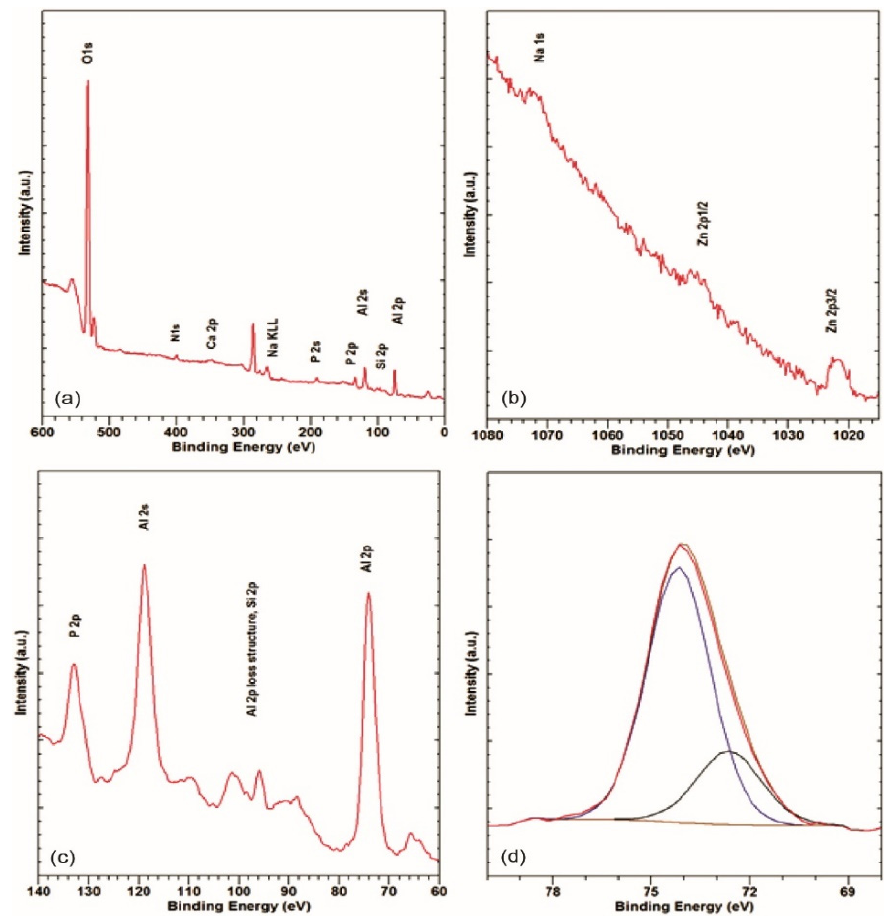
Figure 2. XPS survey ( a ), region around Na 1s, Zn 2p ( b ), 60–140 eV region ( c ), and narrow-range Al 2p ( d ) spectra in the degraded area.